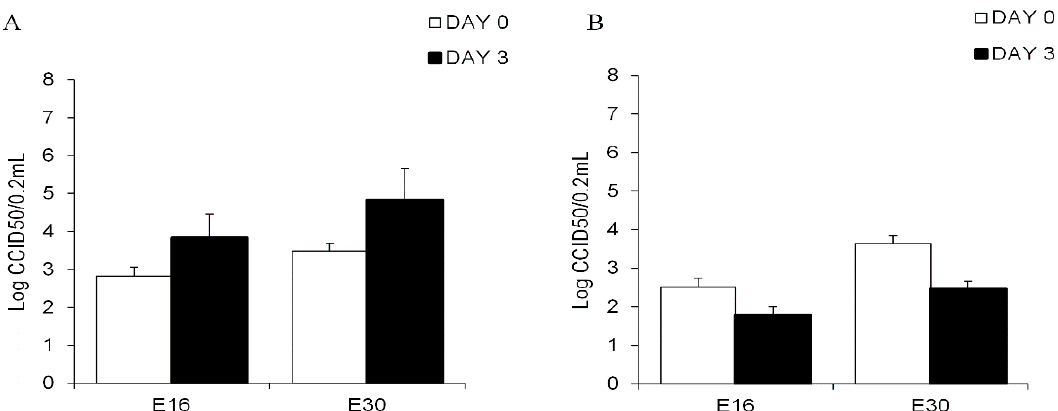
Figure 6. Viral titers of the epidemic strains of E16 and E30 in the culture medium of infected human islets ( A ) and exocrine cells ( B ). Free-floating human exocrine cells from ten donors and islets from seven donors were infected with a 1000 CCID50/0.2 mL of E16 and E30. Aliquots of the culture medium were withdrawn day 0 (empty bar) and day 3 (filled bar). Virus titers were obtained using the CCID50 titration method. Data are presented as log10 (CCID50/0.2 mL), means ± SD from experiment performed in triplicate.